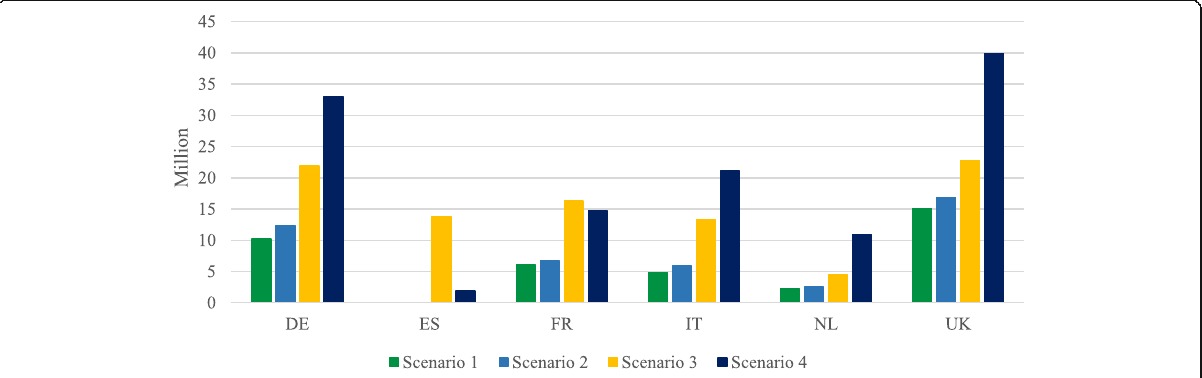
Fig. 19 Estimated return under the four scenarios: the case of Germany, Spain, France, Italy, The Nederland, and the U.K